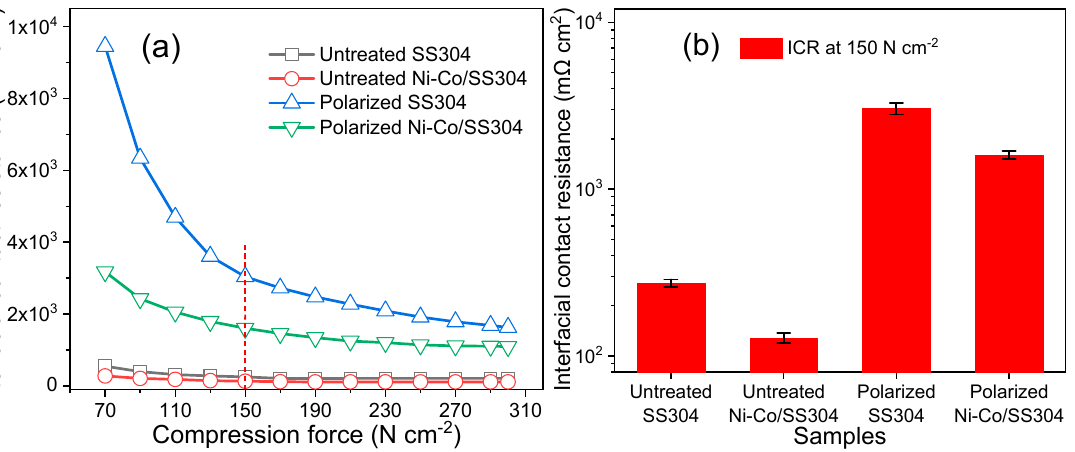
Figure 11. The interfacial contact resistance of SS304 and Ni–Co/SS304 before (untreated) and after polarization (0.6 V, 5 h) in the simulated PEMFC cathode environment: ( a ) ICR at various compression forces; ( b ) ICR at 150 N/cm 2 .